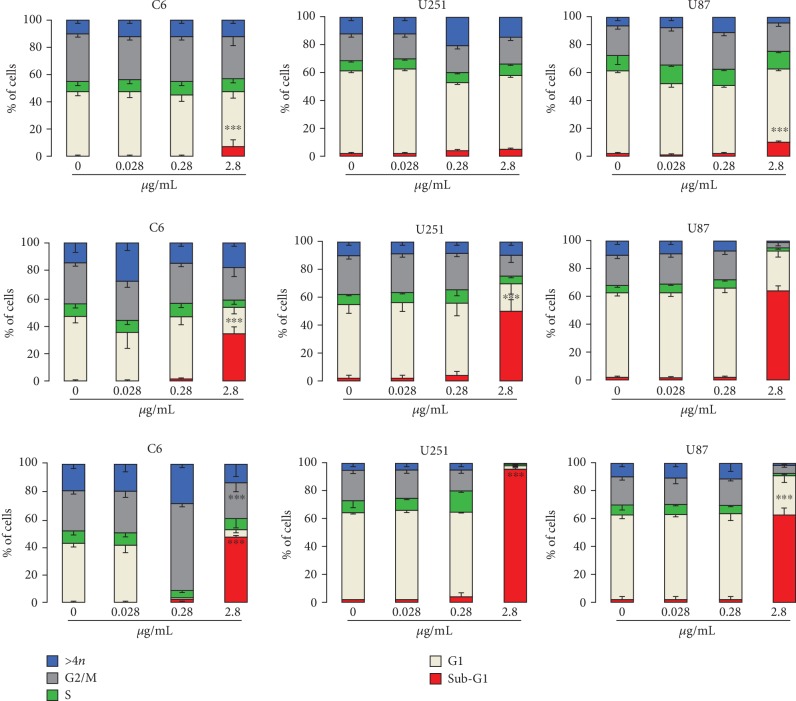
Effect of the DPDT treatment on the cell cycle distribution in U87, U251, and C6 cell lines. The cells were treated for 24, 48, and 72 h (first, second, and third lines, respectively) with DPDT at concentrations of 0.028, 0.28, and 2.8 μg/mL. The values the % of sub-G1, G1, S, and G2/M phases and >4n cells, expressed as the means of four independent experiments, each performed in triplicate. The error bars indicate the standard error of the means. Significantly different at ∗p < 0.05, ∗∗p < 0.01, and ∗∗∗p < 0.001 compared with untreated control cells (one-way ANOVA followed by Tukey test).